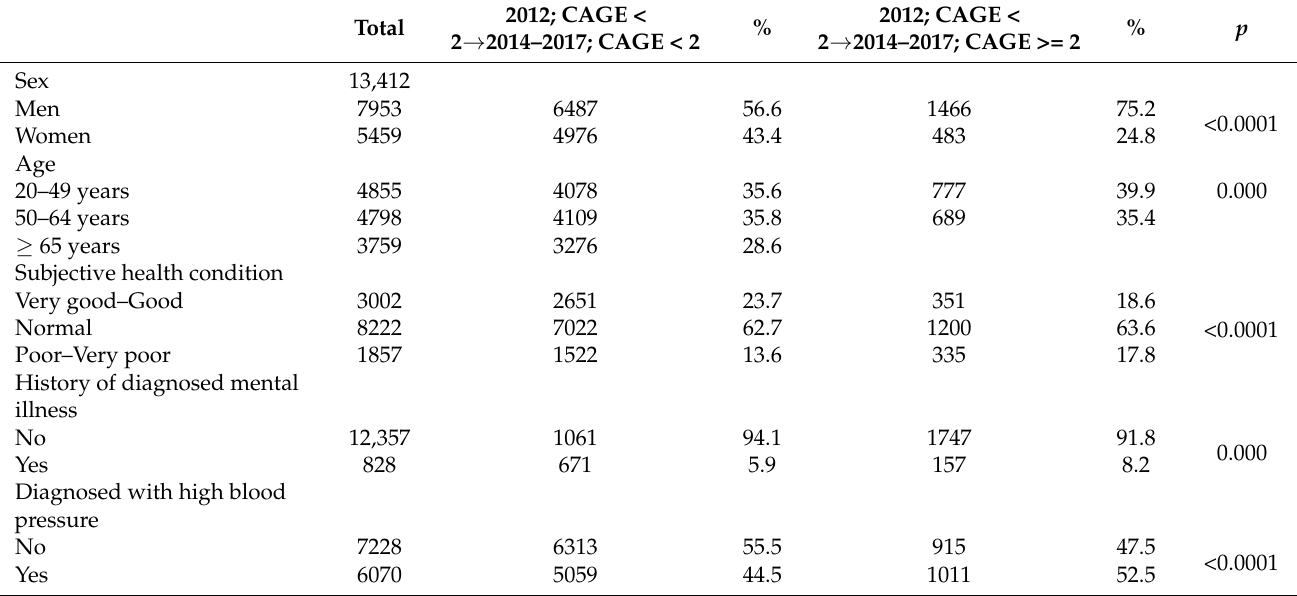
Table A1. Characteristics of participants without problem drinking in FY 2012 but who subsequently developed problem